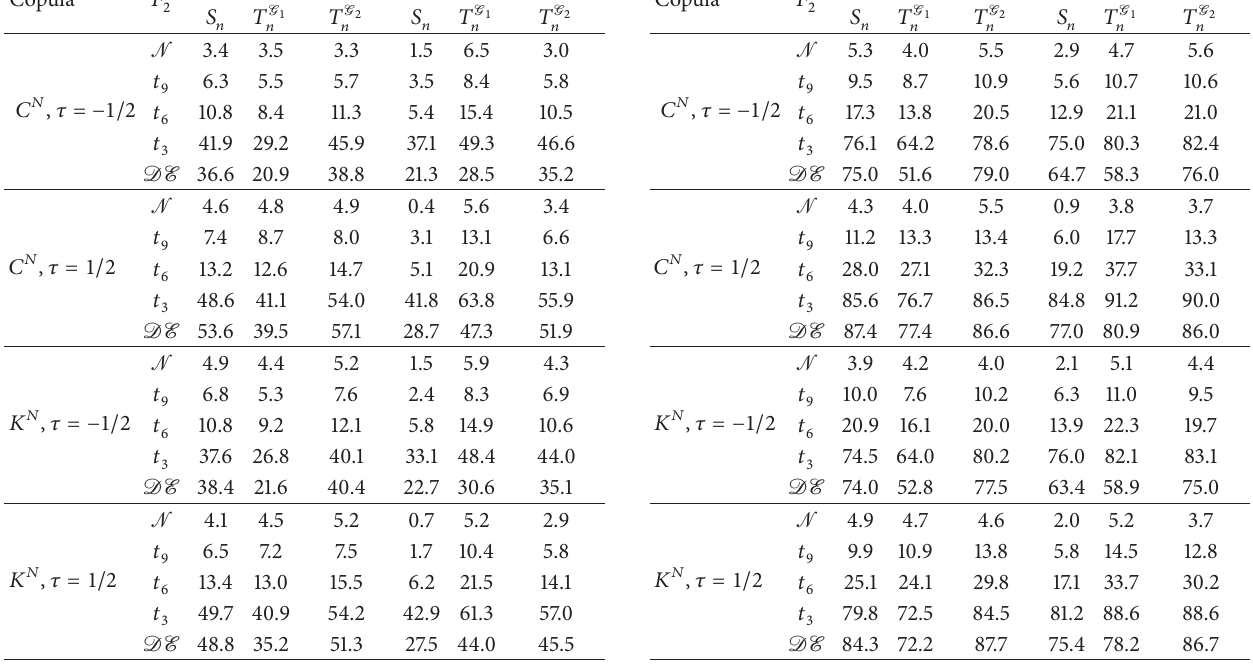
Table 1: Percentages of rejection, as estimated from 1000 replicates, Table 2: Percentages of rejection, as estimated from 1000 replicates, of the null hypothesis of the equality of 𝐾 = 2 distributions up to of the null hypothesis of the equality of 𝐾 = 2 distributions up to location/scale under Normal and asymmetric Normal dependence location/scale under Normal and asymmetric Normal dependence structures when 𝑛 = 100 ; 𝐹 1 is the Normal distribution; 𝐹 2 is either structures when 𝑛 = 200 ; 𝐹 1 is the Normal distribution; 𝐹 2 is either the N , 𝑡 9 , 𝑡 6 , 𝑡 3 , or DE distribution. the N , 𝑡 9 , 𝑡 6 , 𝑡 3 , or DE distribution. Bootstrap method I Bootstrap method II Bootstrap method I Bootstrap method Copula 𝐹 2 Copula 𝐹 2